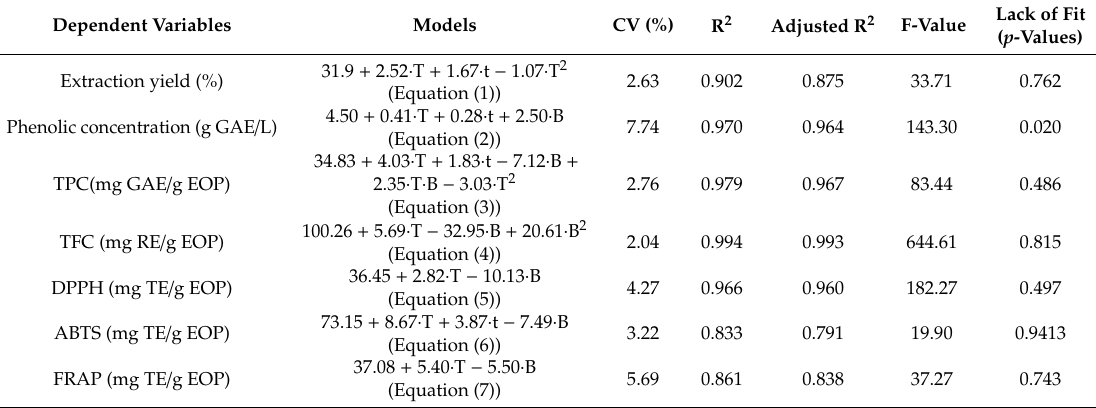
Table 4. Mathematical models and coe ffi cients for the responses using coded